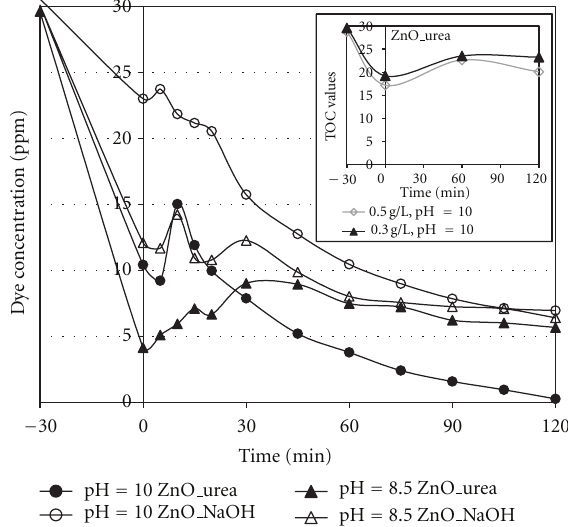
Figure 9: R 6G concentration profile in time (0.3 g/L photocatalyst, 30ppm/L dye) and TOC values for ZnO-urea sample, at pH = 10 and two photocatalyst